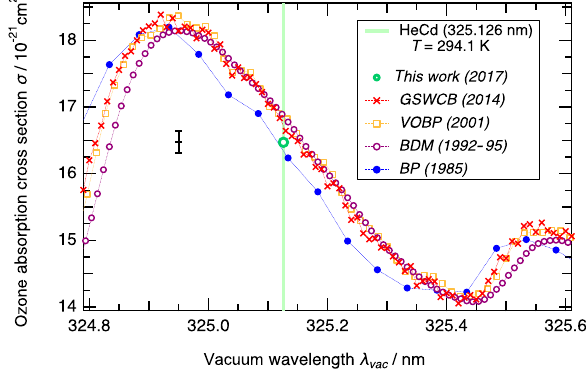
Figure 6. Comparison of high-resolution ozone absorption data around the 325nm HeCd laser line (position indicated by vertical bar). The vacuum wavelength is used on the ordinate scale. Data are from the same sources as in Table 5. Straight lines between measurement points were inserted for visual guidance. Individual uncertainty bars have been omitted from the graph. The uncertain- ties of this work are smaller than the symbol size. Uncertainty as- signments for other spectra are given in Table 5. As a reference, the black vertical bar indicates the ± 1% relative uncertainty range at 1 . 647 × 10 − 20 cm 2